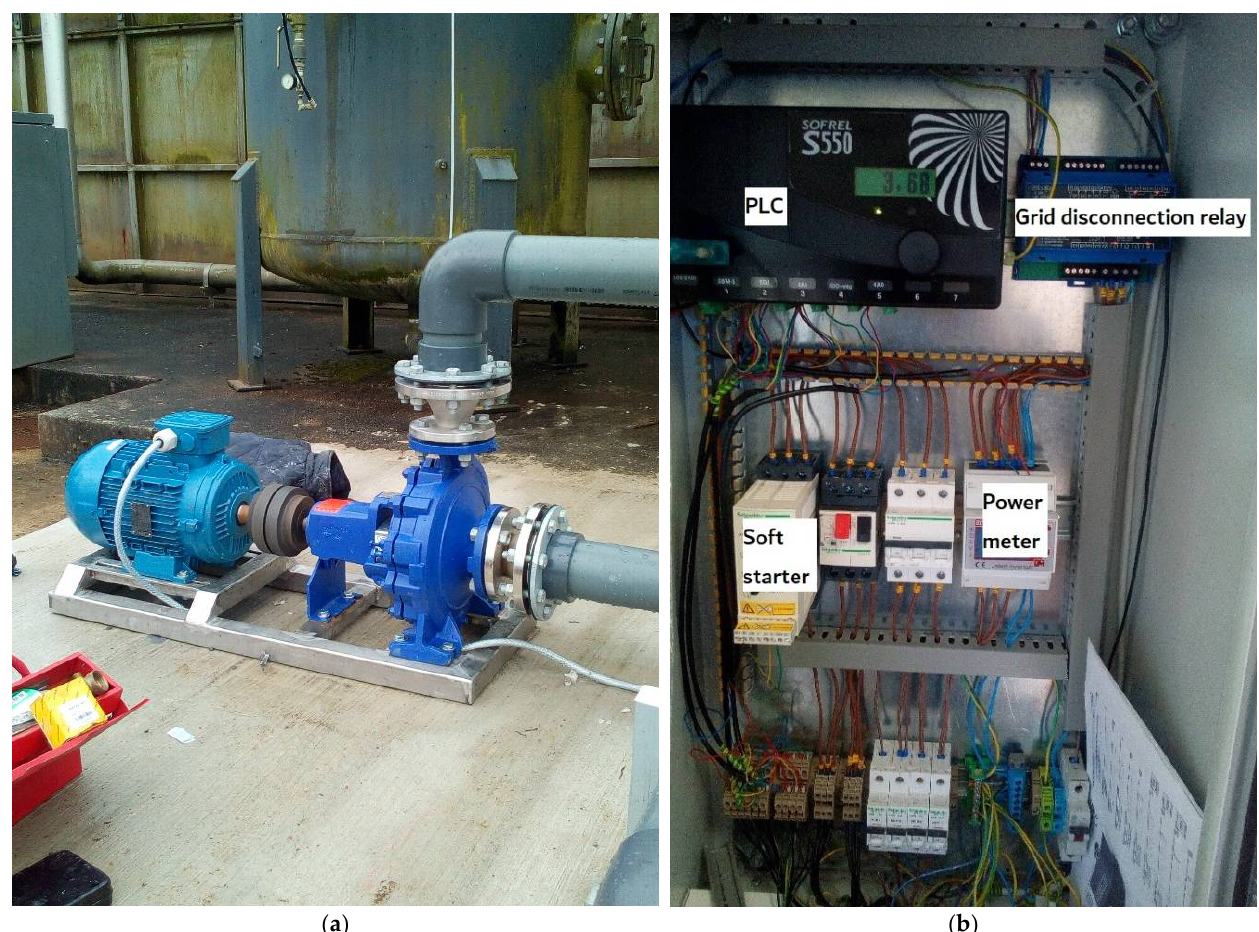
Figure 7. View of the installed energy recovery scheme. ( a ) PAT and generator. ( b ) Electric and control panel.